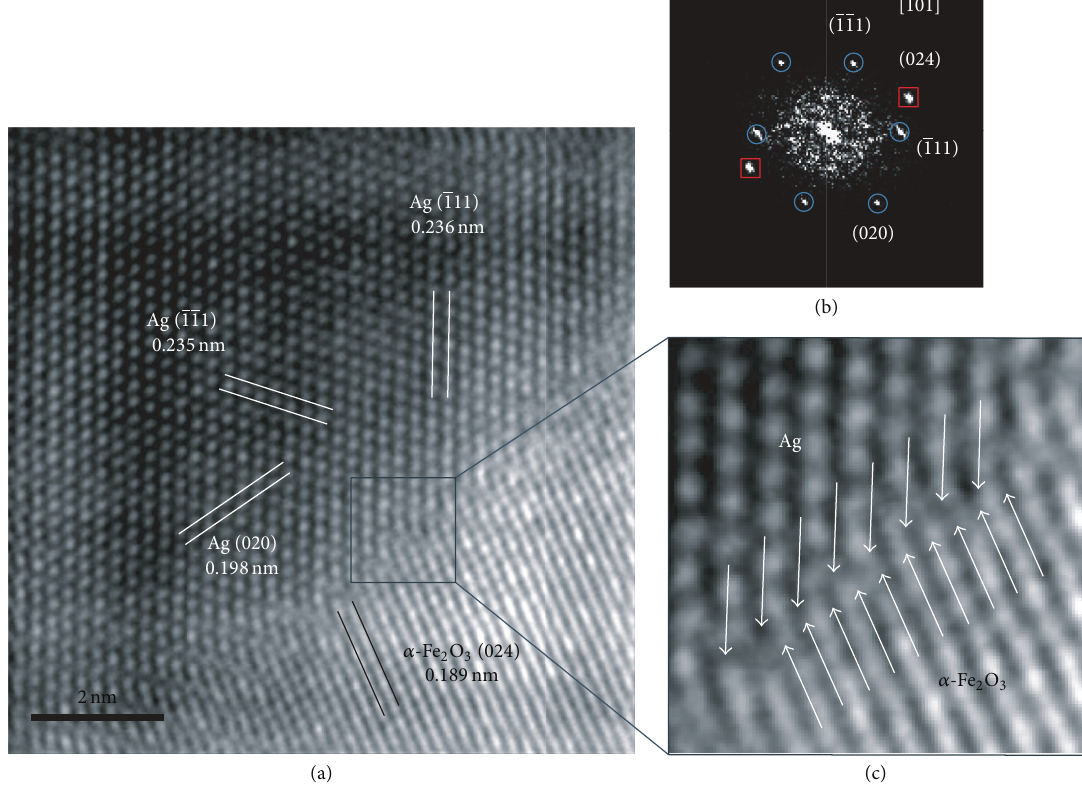
Figure2:(a)HREMimageofthe 𝛼 -Fe 2 O 3 -Aginterface,(b)FFToftheHREMimageassociatedwiththe 𝛼 -Fe 2 O 3 -Agbimetallicnanoparticles, and (c) HREM filtered image of dumbbell-like